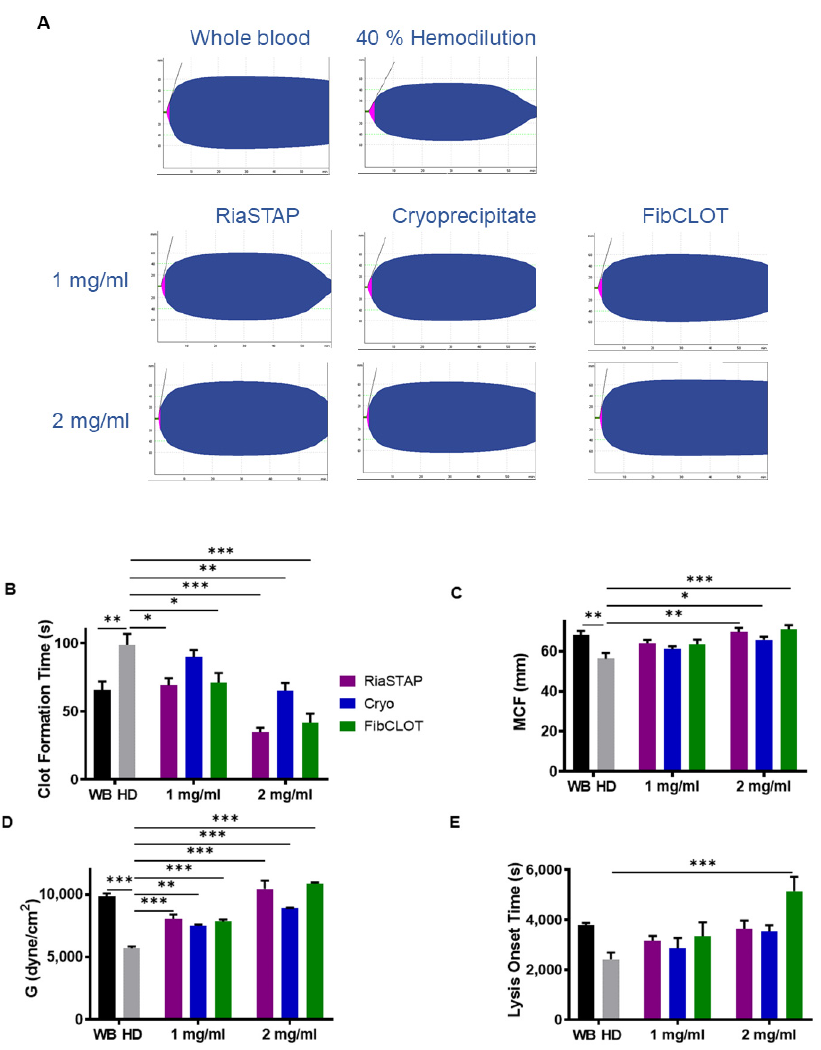
Figure 6. Effect of hemodilution on thromboelastography parameters in the presence of tPA. Throm- boelastography was performed on whole blood or blood diluted by 40% (HD) + 0.4 nM tPA ± 1 or 2 mg/mL, RiaSTAP ® cryoprecipitate or FibCLOT ® using EXTEM reagent. ( A ) Representative throm- boelastography traces, ( B ) clot formation time (CFT), ( C ) maximum clot firmness (MCF), ( D ) clot elasticity and ( E ) lysis onset time. * p < 0.05, ** p < 0.01, *** p < 0.001, vs. HD. n = 3.